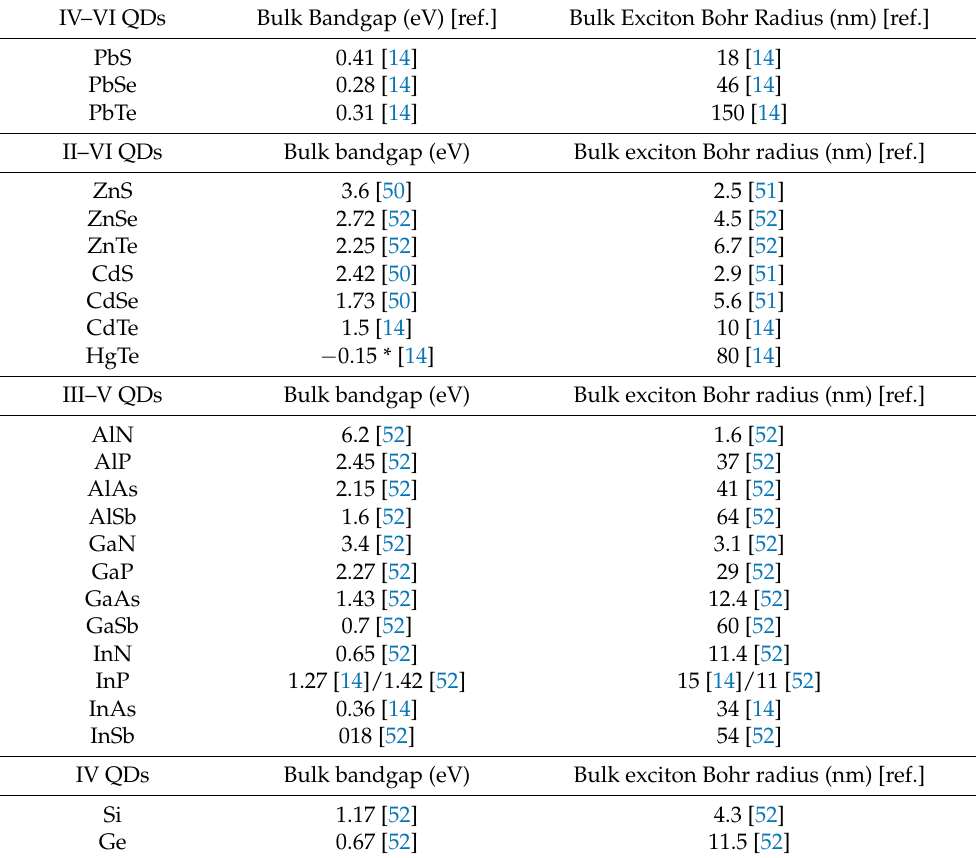
Table 2. Bandgap energy and exciton Bohr radius of some semiconductor inorganic materials, which are commonly used in QDs. Values of bulk semiconductor materials vary depending on the literature because various methods have been used to obtain